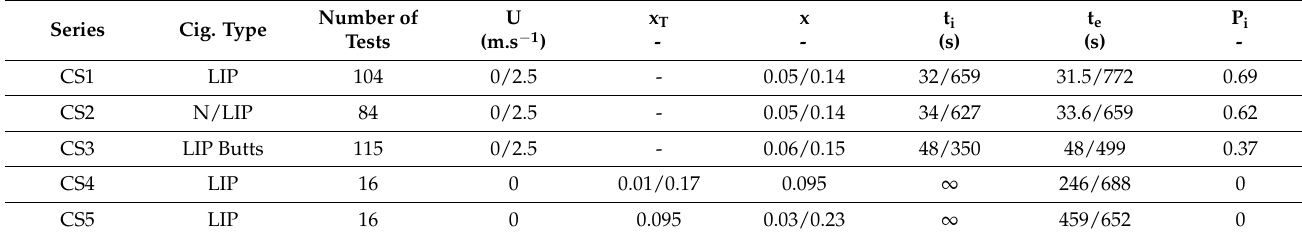
Table 4. Main parameters of the ignition tests with cigarettes and straw fuel beds. Series Cig.